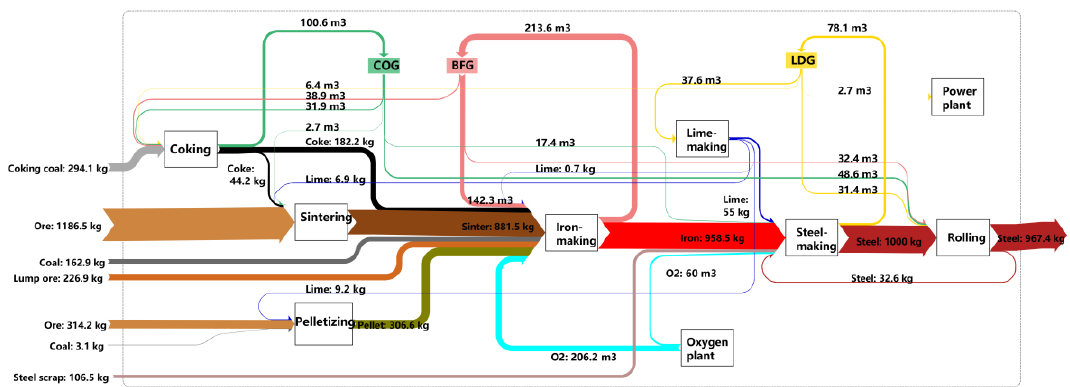
Figure 5. Chart of the material flows of an ISP with the TGR-OBF.